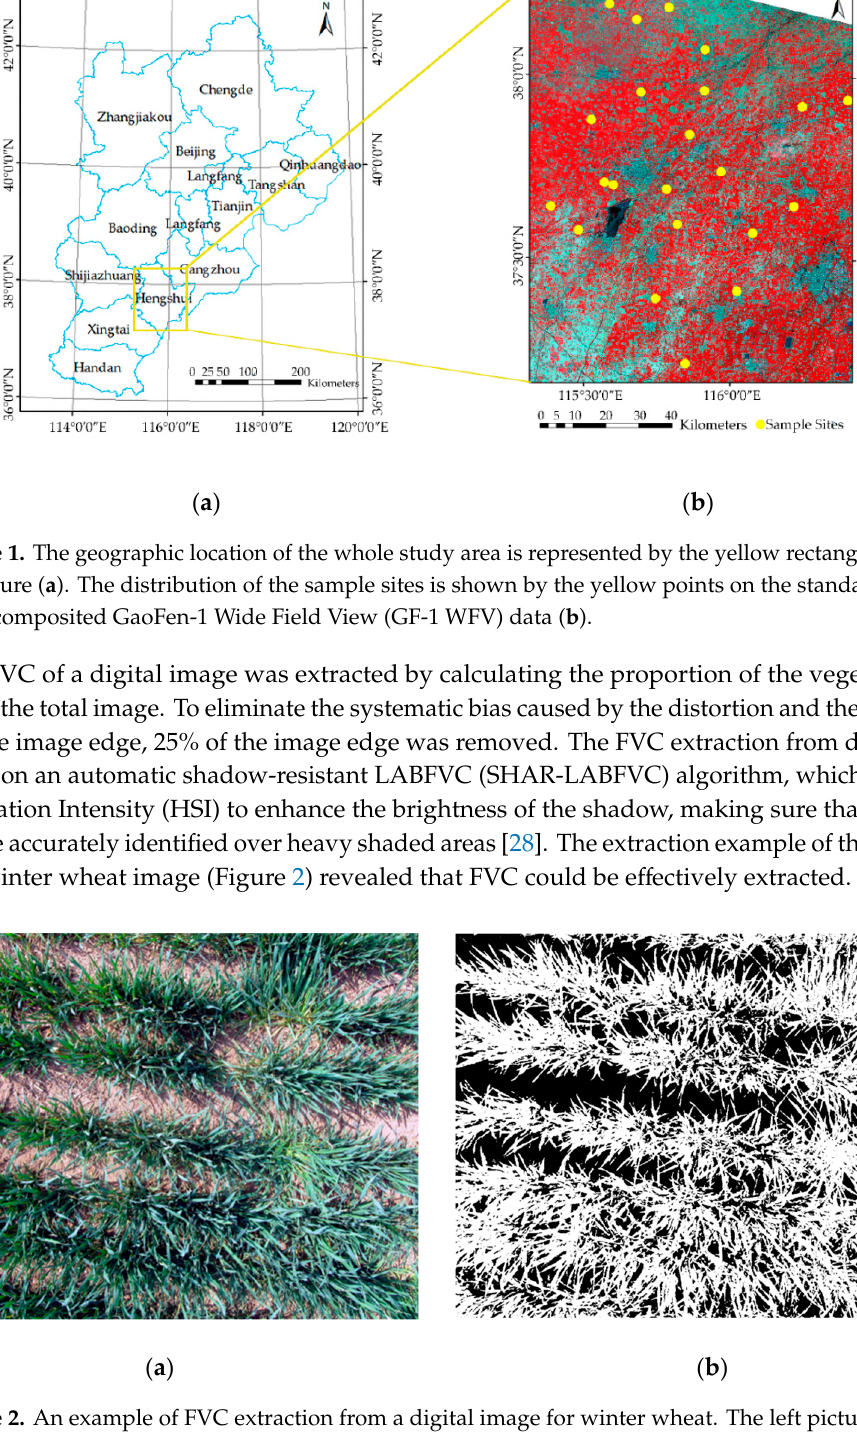
Figure 1. The geographic location of the whole study area is represented by the yellow rectangle in the left figure ( a ). The distribution of the sample sites is shown by the yellow points on the standard false color composited GaoFen-1 Wide Field View (GF-1 WFV) data ( b ).